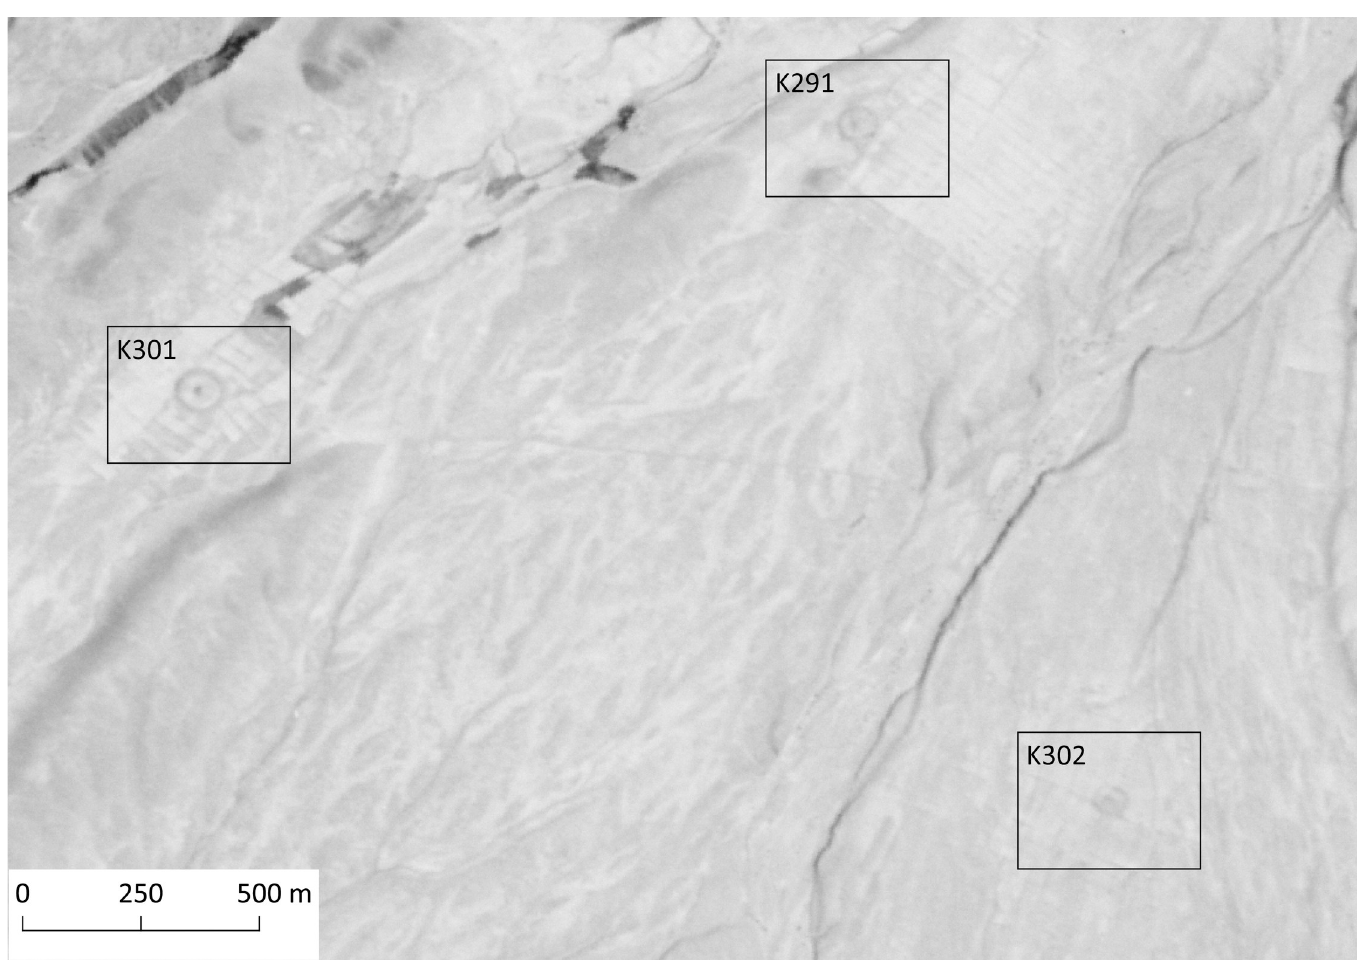
Fig 7. Group of stupas: K291, K301, and K302. CORONA Satellite image courtesy of the U.S. Geological Survey (DS1021-2119DF015_b, 05.26.1965) (https://